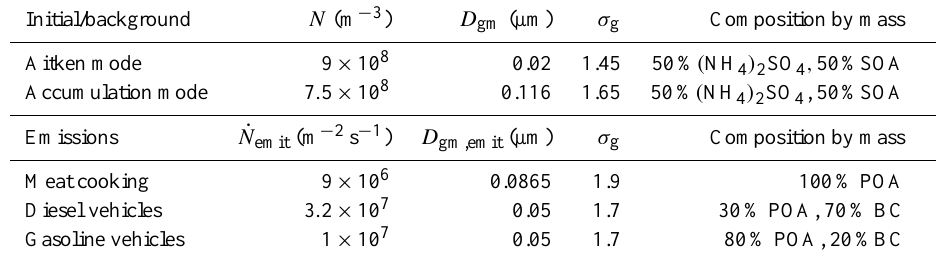
Table 1. Aerosol emissions and initial conditions for baseline simulation.